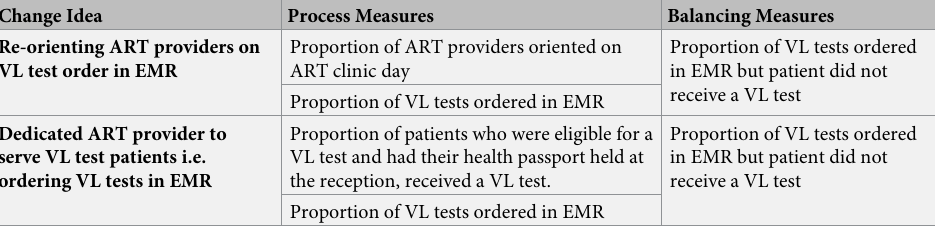
Table 1. Change ideas, process and balancing